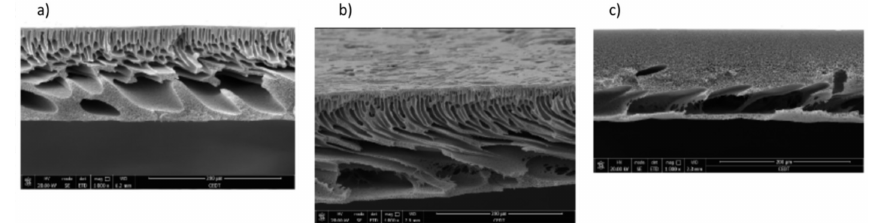
Figure 8. Cross-section images of: ( a ) PES membrane; ( b ) PES-AgNPs (0.32 wt %) membrane; and ( c ) PES-AgNPs (0.64 wt %) membrane, adapted from Rehan et al.